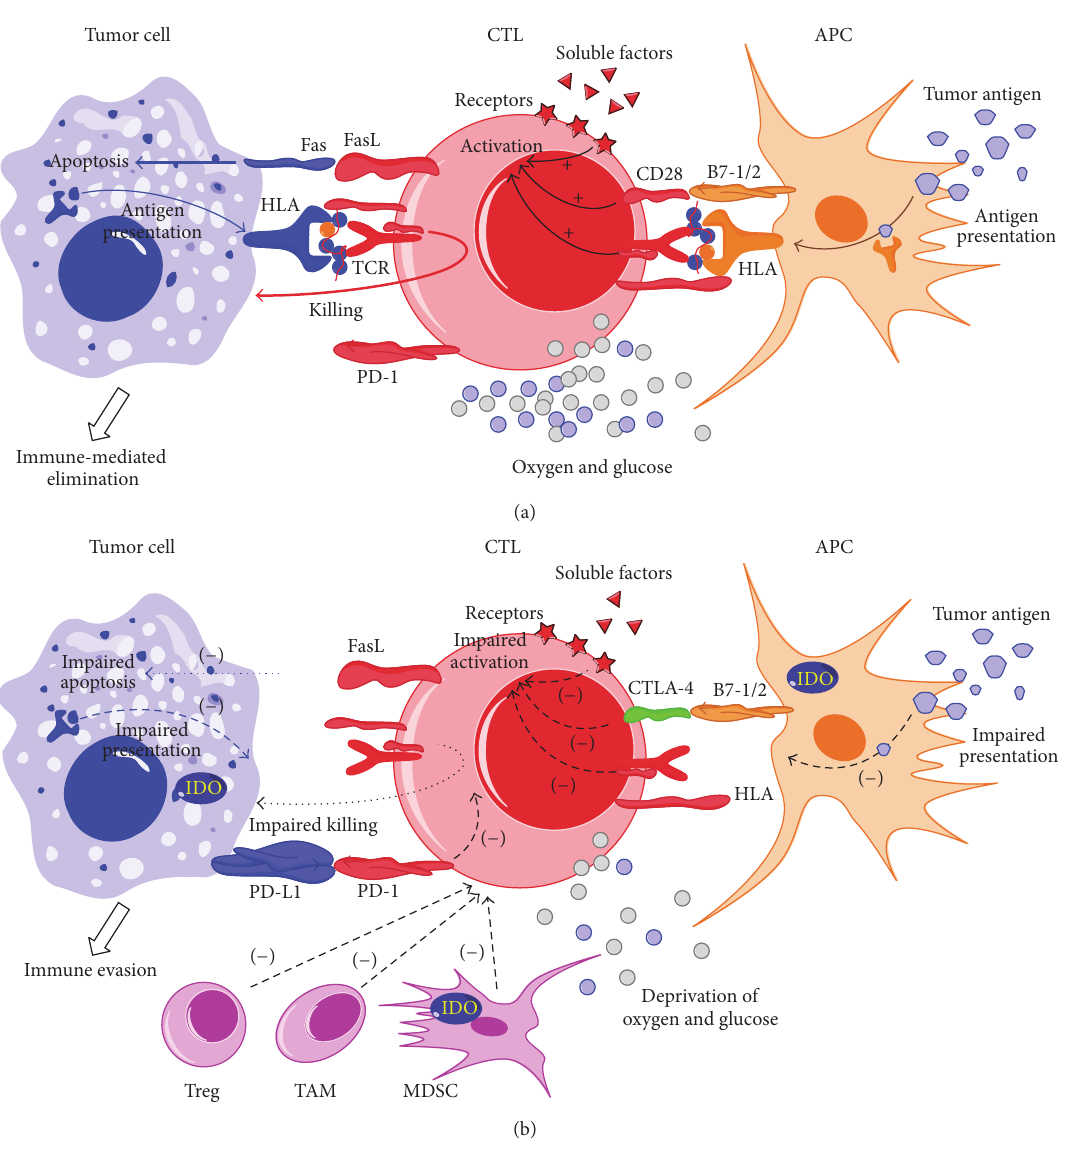
Figure 1: Immune-mediated elimination by cytotoxic T lymphocytes (CTLs) and tumor immune evasion strategies that are dependent on or independent of targeted recognition of CTLs on tumor cells in hematological malignancies. (a) Antigen presenting cells (APCs) uptake and present tumor antigens on the cell surface in an HLA-dependent manner, providing costimulatory signals (e.g., B7-1/2) for priming the T-cell response. Upon activation by APCs, CTLs can recognize the tumor cells with the presentation of tumor antigens in the context of proper metabolism (e.g., sufficient oxygen and glycose). Subsequently, CTLs kill tumor cells by releasing perforin and granzyme B or by expressing Fas ligand (FasL) on the surface, inducing cytolysis or apoptosis. (b) CTL-mediated immunity can be suppressed by targeted recognition- dependent and targeted recognition-independent mechanisms, leading to immune evasion in hematological malignancies. Strategies including dysfunctional APCs, defective costimulation, and impaired antigen presentation represent targeted recognition dependent immune evasion. In contrast, strategies including immune checkpoint pathways (e.g., CTLA-4 or PD-1/PD-1L), suppressive immune cells (e.g., Treg cell, tumor-associated macrophage TAM, myeloid-derived suppressor cell, and MDSC), tumor altered metabolism (IDO upregulation, oxygen, and glycose deprivation), and regulatory soluble factors (e.g., decreased IL-12) represent approaches independent of targeted recognition of CTLs on tumor